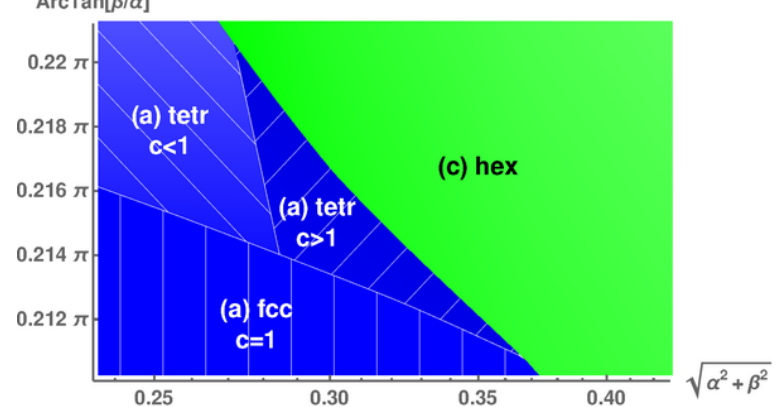
Figure 12: Zoom of the phase diagram in the critical region of fig.